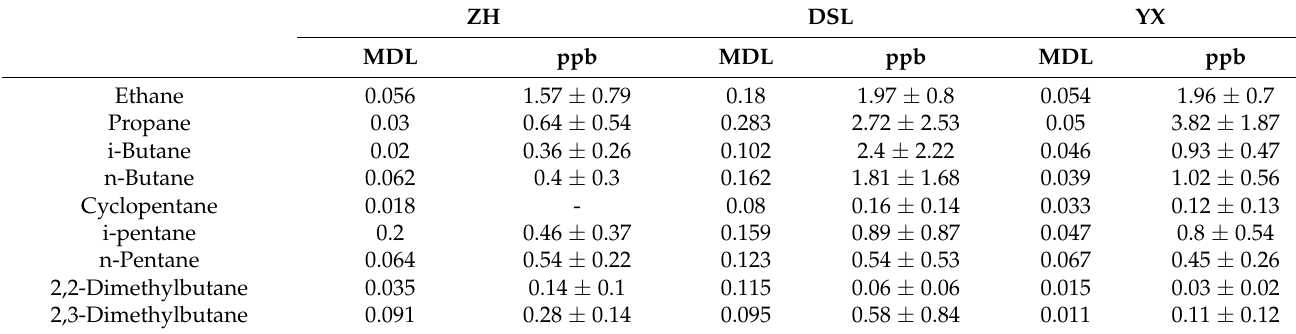
Table 2. VOCs mole ratios (mean ± standard deviation) during the sampling period at the ZH, DSL and YX sites. ZH DSL YX MDL